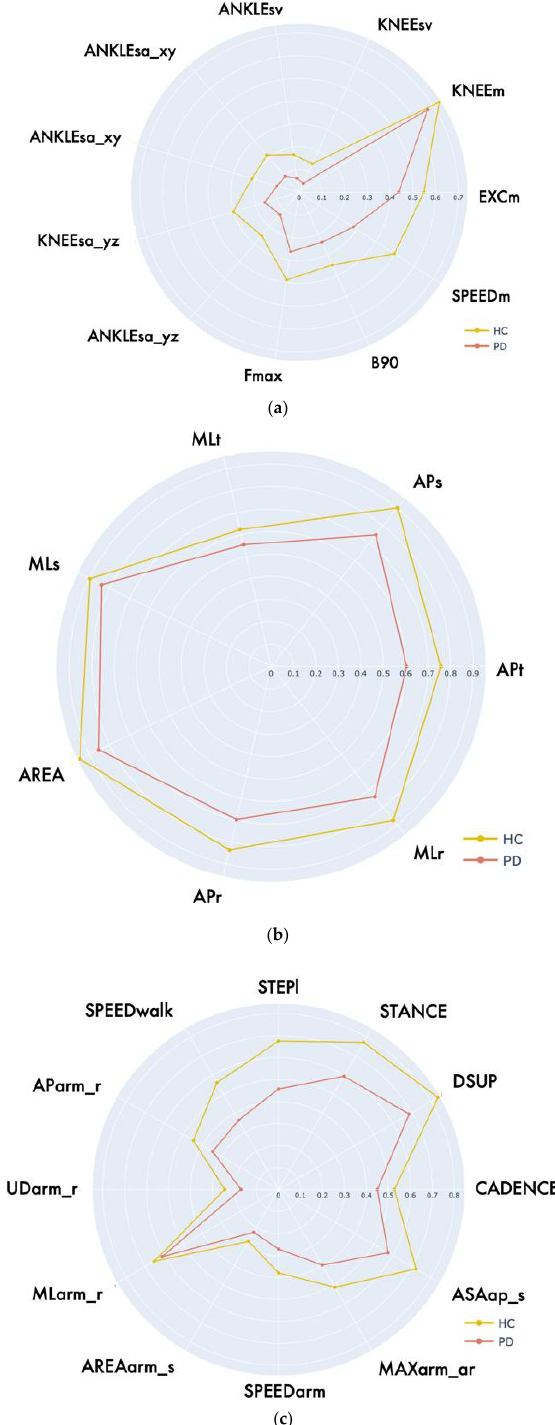
Figure 3. Radar charts of the normalized parameters of PD and HC subjects for all the UPDRS motor tasks: ( a ) leg Agility task; ( b ) postural Stability task; ( c ) gait task.